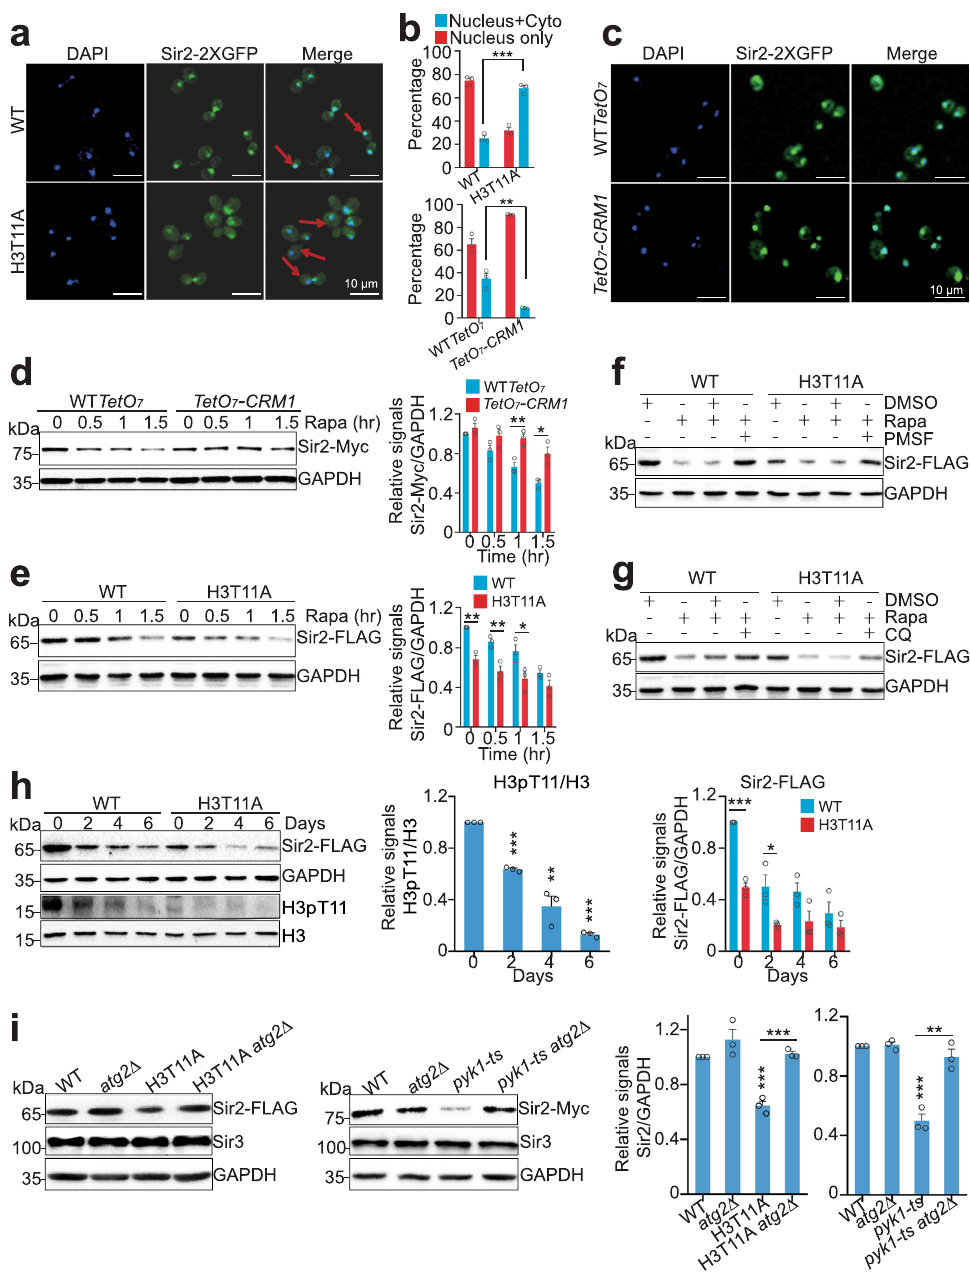
Fig. 5 SESAME-catalyzed H3pT11 prevent the nuclear export of Sir2 and autophagy-mediated Sir2 degradation. a Representative fl uorescence images showing the distribution of Sir2-2xGFP (green) in WT and H3T11A cells expressing Sir2-2xGFP from the native SIR2 locus. The nucleus DNA was stained with 4 ’ ,6-diamidino-2-phenylindole (DAPI) as shown in blue. There was more Sir2 diffuse throughout the cell in H3T11A mutant compared with WT. Arrows indicate the nucleus-localized Sir2 in WT and cytoplasm-localized Sir2 H3T11A mutant, respectively. Bar, 10 μ m. b Quanti fi cation of Sir2-2xGFP localization in cells displayed in Fig. 5a, c, respectively. The bar graphs represent the percentages of cells exhibiting Sir2-2xGFP localized in the nucleus (Nucleus only), or exported to the cytoplasm (Nucleus + Cyto). Data show mean ± SE from at least three biological independent experiments, with ∼ 350 cells counted for each strain per experiment. c Knockdown of CRM1 expression retained most Sir2 in the nucleus. WT TetO 7 and TetO 7 -CRM1 cells grown in YPD medium were treated with 6.25 μ g/ml doxycycline for 1.5 h followed by fl uorescence microscopy. Bar, 10 μ m. d Knockdown of CRM1 expression partly rescued rapamycin-reduced Sir2. WT TetO 7 and TetO 7 -CRM1 cells grown in YPD medium were treated with 6.25 μ g/ml doxycycline and rapamycin for 0 – 1.5 h. e The global Sir2 protein levels in H3T11A mutant were signi fi cantly lower than those in WT when treated with rapamycin. f , g Rapamycin-reduced Sir2 in H3T11A mutant was partly rescued by PMSF ( f ) and CQ ( g ) treatments. h Western blots analysis of Sir2 and H3pT11 in WT and H3T11A mutant when aged for 0 – 6 days in YPD medium. i Western blots showing deletion of ATG2 rescued the reduced Sir2 in H3T11A and pyk1-ts mutants. For WT, atg2 Δ , pyk1-ts , and pyk1-ts atg2 Δ mutants, these four strains were treated at 37 °C for 2 h. For Fig. 5b, d, e, h, i, the quantitative data represent means ± SE; n = 3 biological independent experiments. Statistical signi fi cance was tested using two-sided Student ’ s t test. * p < 0.05; ** p < 0.01; *** p < 0.001. For Fig. 5f, g, shown are the typical example of three biological independent experiments.